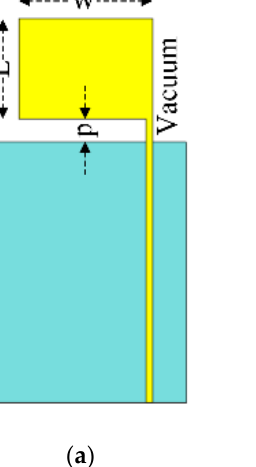
Figure 2. Inverted L-shaped planar monopole antenna on the partial ground plane: ( a ) in vacuum, ( b ) with FR-4 substrate.